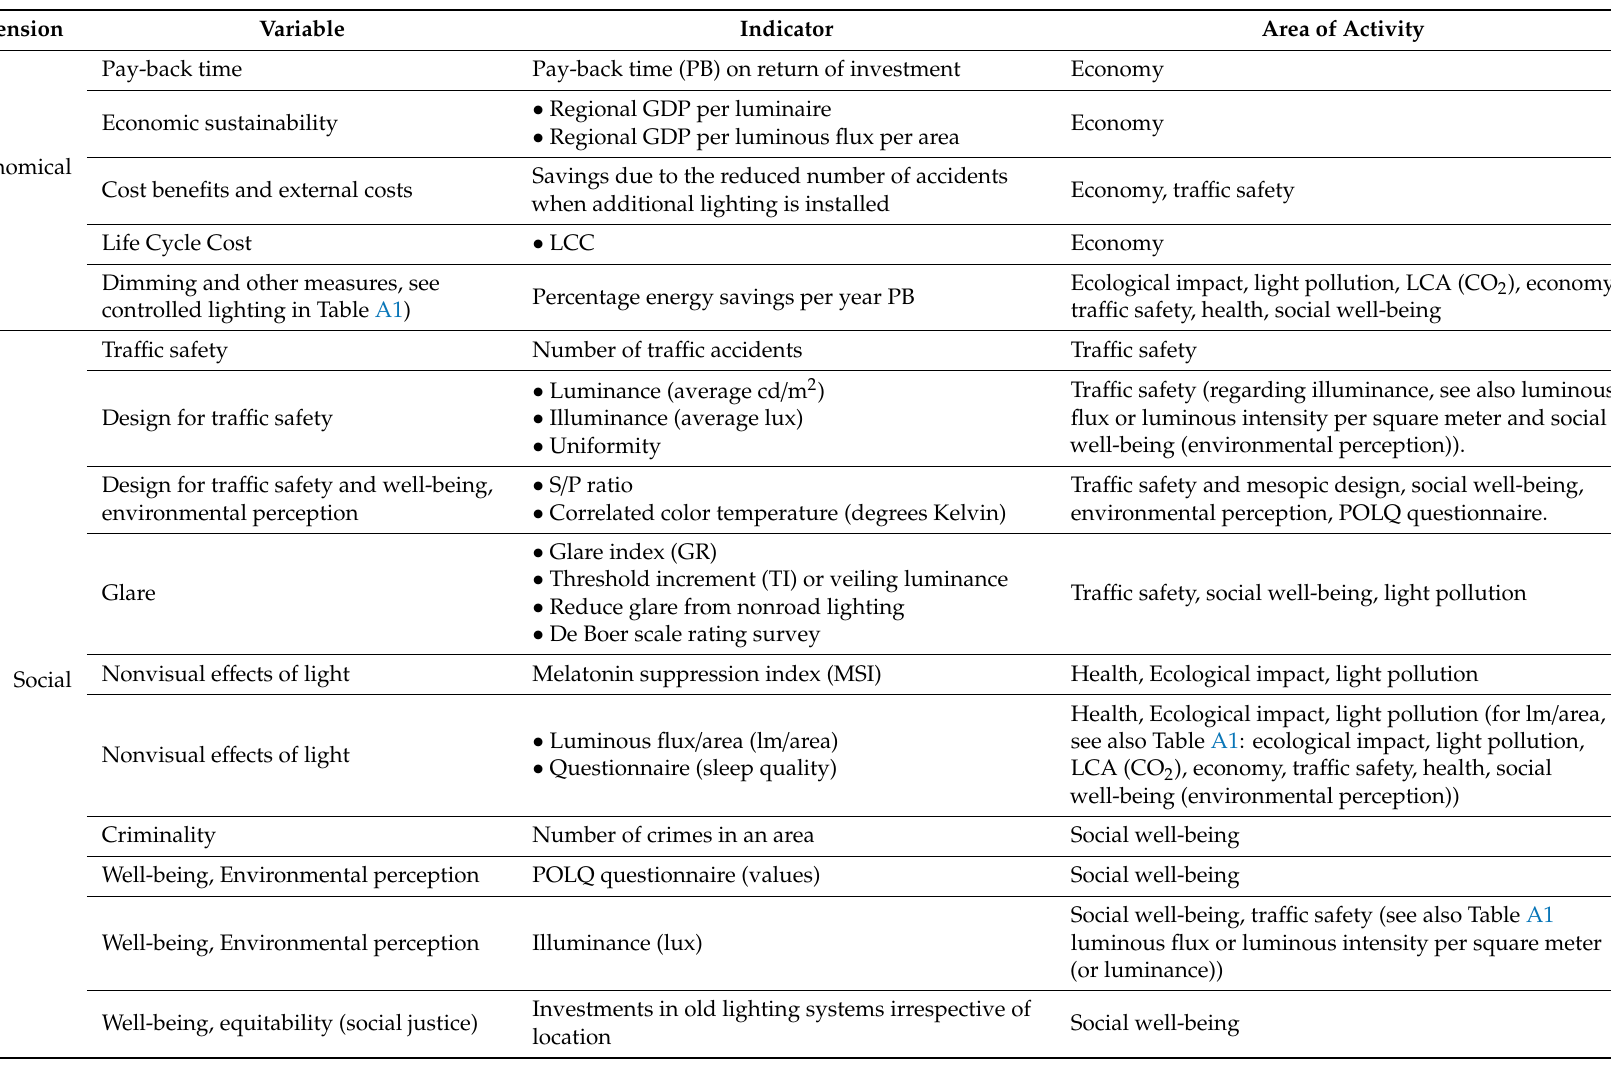
Table A2. Indicators and variables of sustainable development in the economic and social dimensions and area of